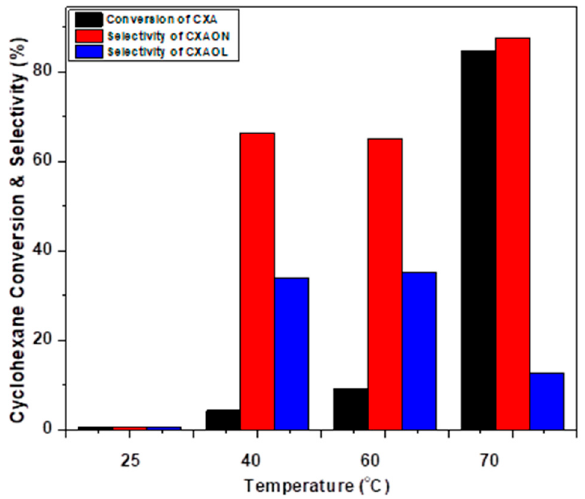
Figure 8. The oxidation of cyclohexane by m -CPBA for 24 h using different temperatures.